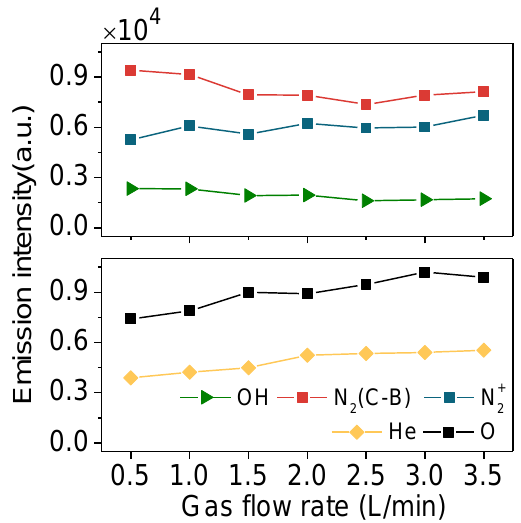
Figure 11. Effects of helium flow rate on the emission intensity of N 2 (C 3 Π u → B 3 Π g ), N + (B 2 Σ → X 2 Π ), OH (A 2 Σ → X 2 Π ), O (3p 5 P → 3s 5 S 0 ), and He (3s 3 S → 2p 3 P 0